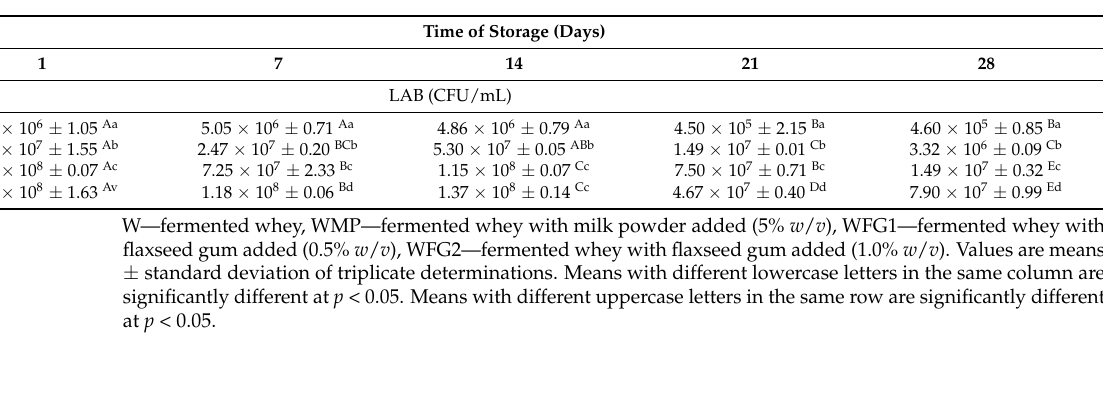
Table 1. The lactic acid bacteria (LAB) survivability during storage